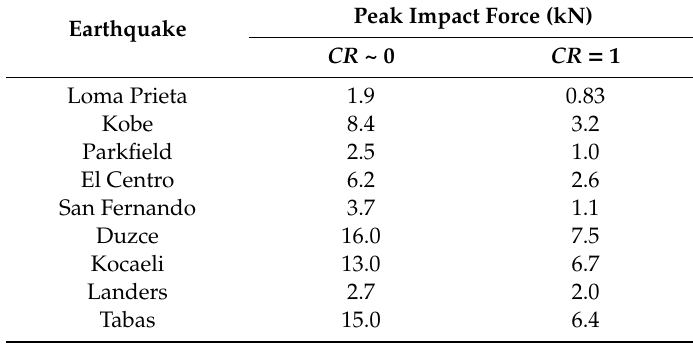
Figure 9. Peak impact force with relation to coe ffi cient of restitution. Table 5. Peak impact forces for two extreme values of coe ffi cient of